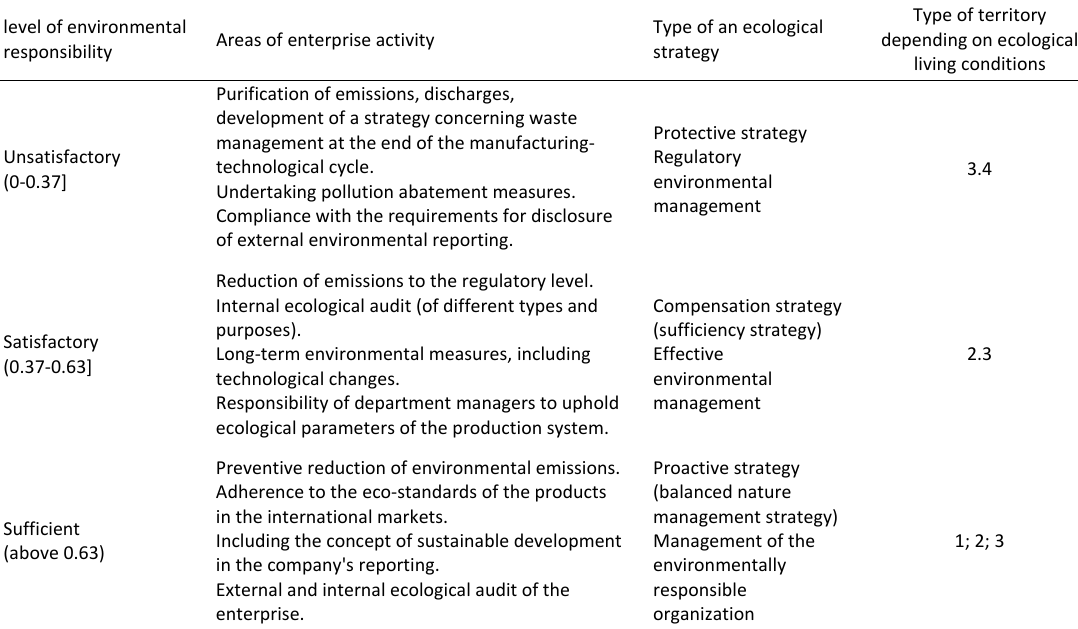
Table 9: Ecological strategy for the development of industrial enterprises* level of environmental responsibility